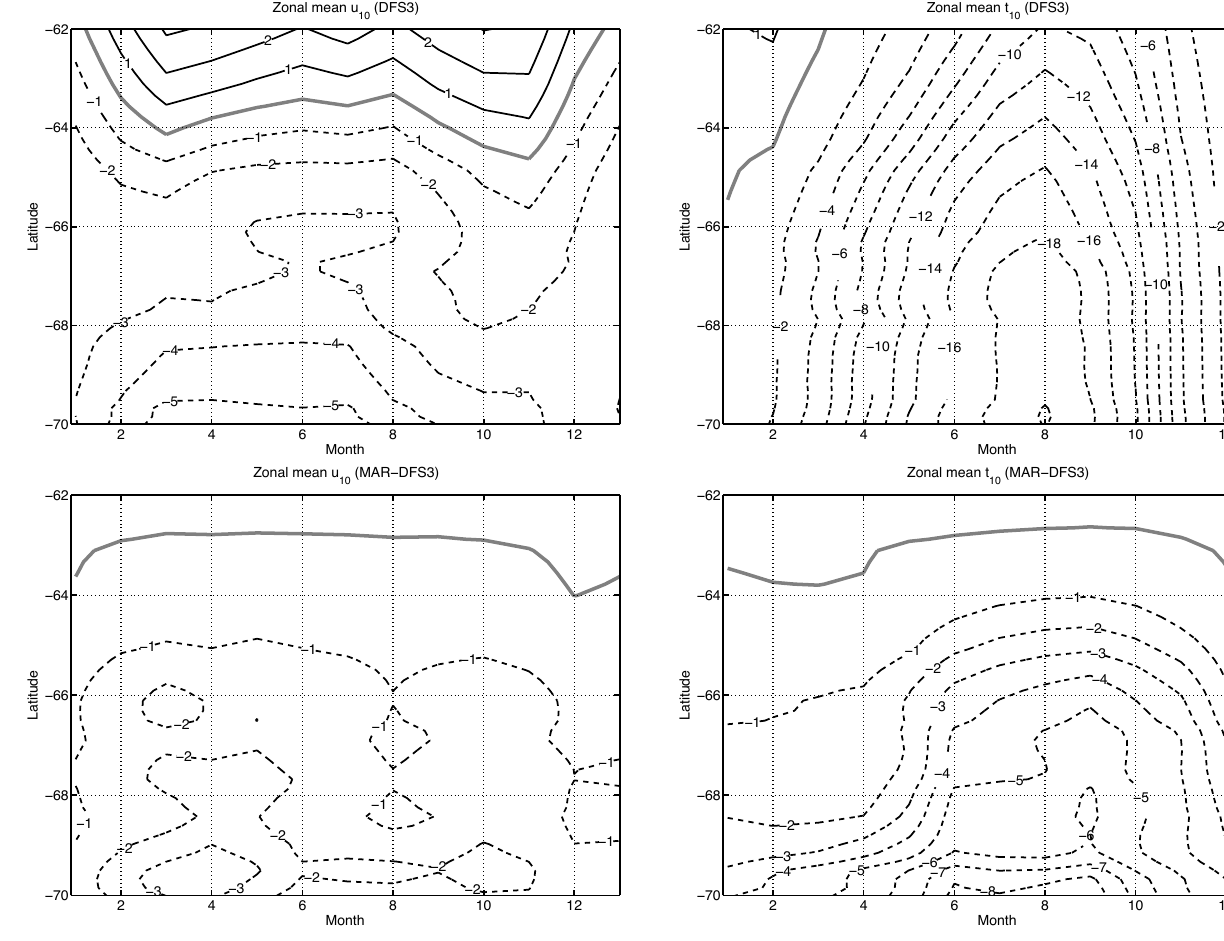
Fig. 2. Zonal average (0 ◦ E–150 ◦ E) of the zonal mean component of the wind speed (u 10 ) over 1980–1989 in DFS3 (top) and of the difference of u 10 between MAR and DFS3 (bottom). In the upper figure, black lines correspond to a westerly wind and black dashed lines to an easterly wind. In the lower figure, a black dashed line corresponds to a stronger easterly wind in MAR and the thick grey line corresponds to the 0 difference line.